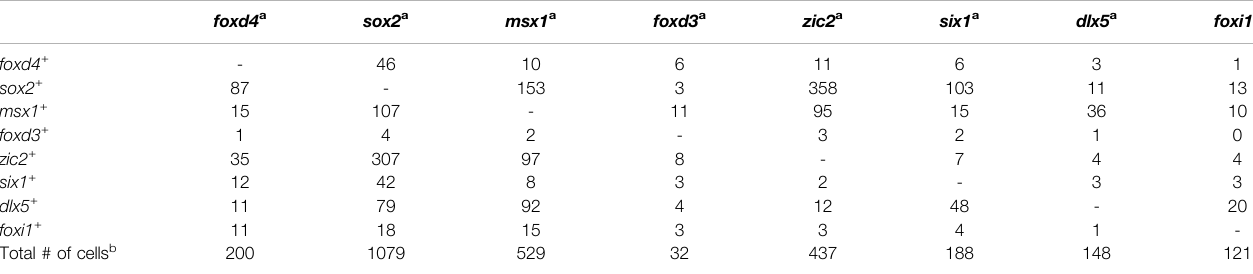
TABLE 5 | The number of single cells co-expressing at least two domain-enriched transcription factors at stage